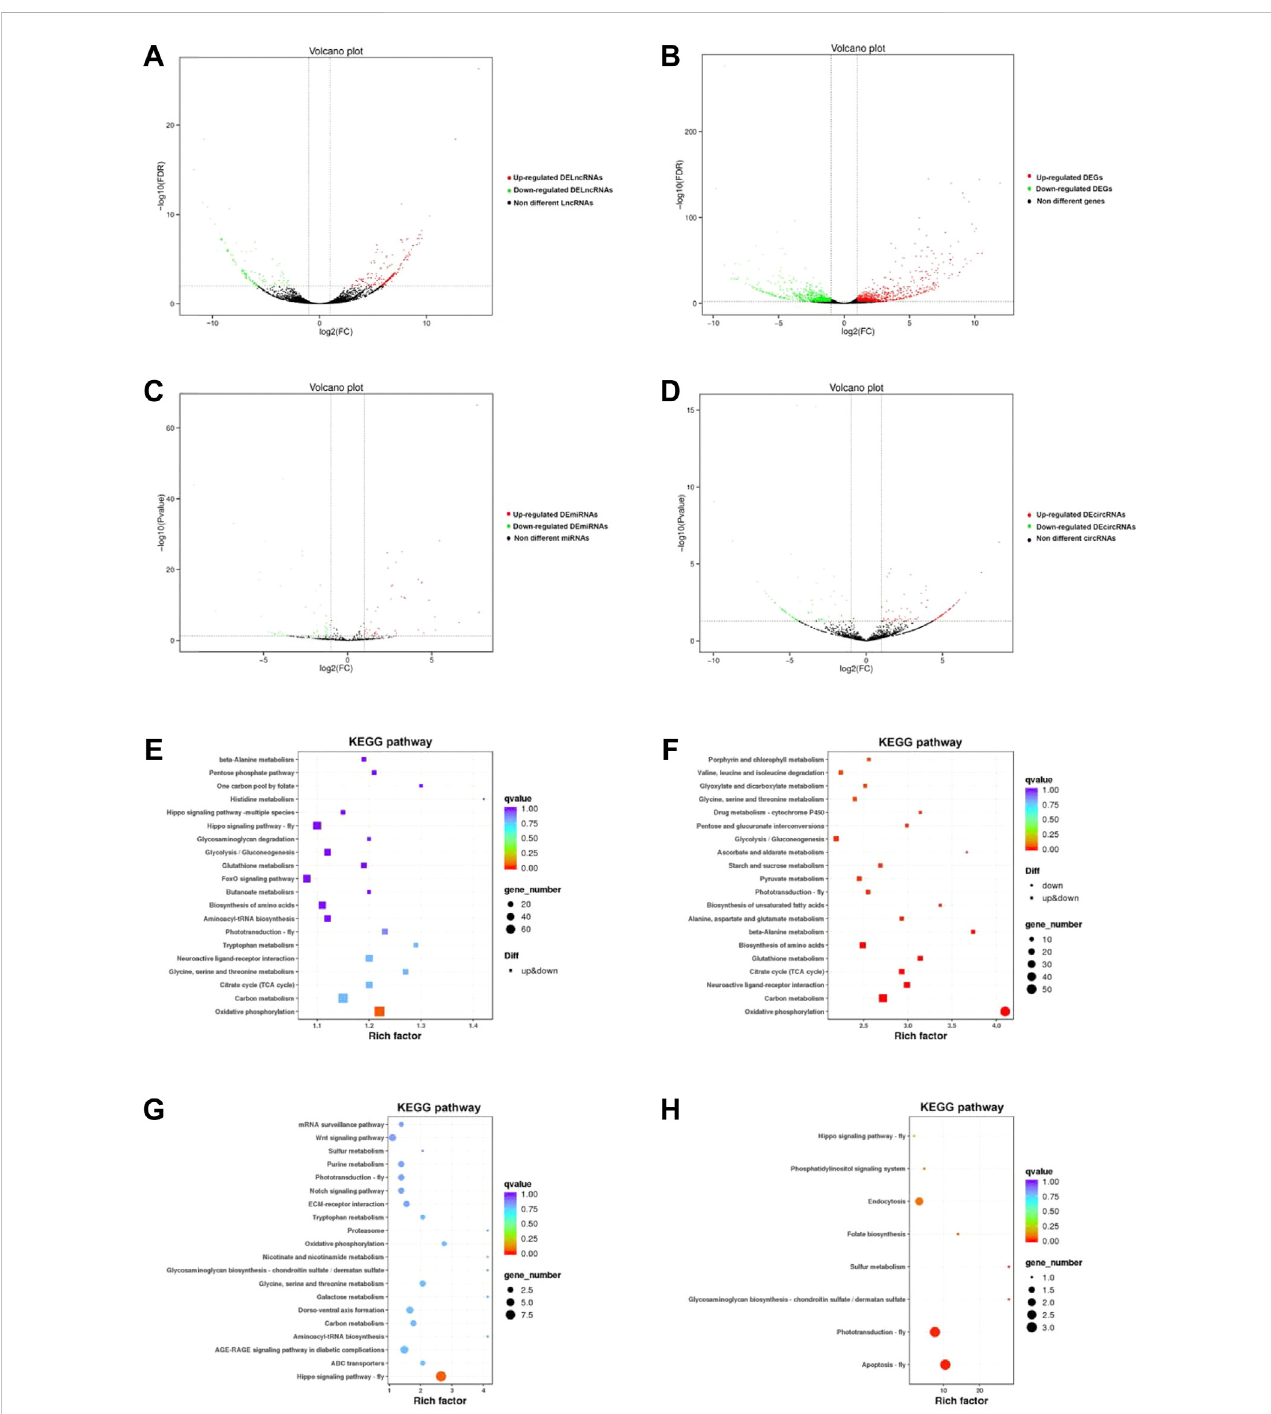
FIGURE 2 (A) The volcano diagram of lncRNAs between NC and NQ. The red spots represent upregulated DElncRNAs in NQ compared to CQ, whereas the green spotsrepresentdownregulatedDElncRNAs;Theblackspotsarenon-different lncRNAs. (B) Thevolcano diagramofDEGsbetween NCandNQ.Theredspots represent upregulated DEGs in NQ compared to CQ, whereas the green spots represent downregulated DEGs. lncRNAs with FDR < 0.05, |log2 (Fold change) | S 1 were identi fi ed as DElncRNAs. Same to DEGs, DEmiRNAs and DEcircRNAs. (C) The volcano diagram of miRNAs between NC and NQ. The red spots represent upregulated DEmiRNAs in NQ, whereas green spots represent downregulated DEmiRNAs. (D) The volcano diagram of circRNAs between NC and NQ.TheredspotsrepresentupregulatedDEcircRNAsinNQ,whereasgreenspotsrepresentdownregulatedDEcircRNAs. (E – H) arethetoppathwaysofKEGG enrichment of DEGs, DElncRNAs, DEmiRNAs and DEcircRNAs respectively. The sizes of circles represent the number of DEGs, DElncRNAs, DEmiRNAs, and DEcircRNAs, and the colors of circles represent the p -values of